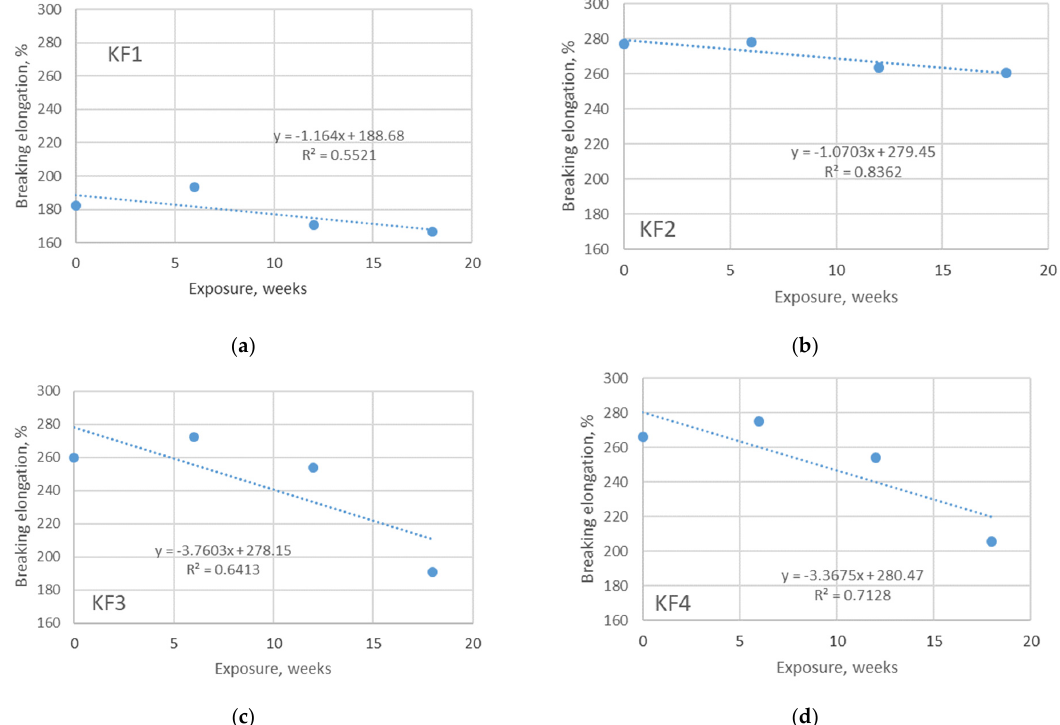
Figure 7. Breaking elongation of materials exposed to aging in pool water, outdoor. The overview is given for: ( a ) material